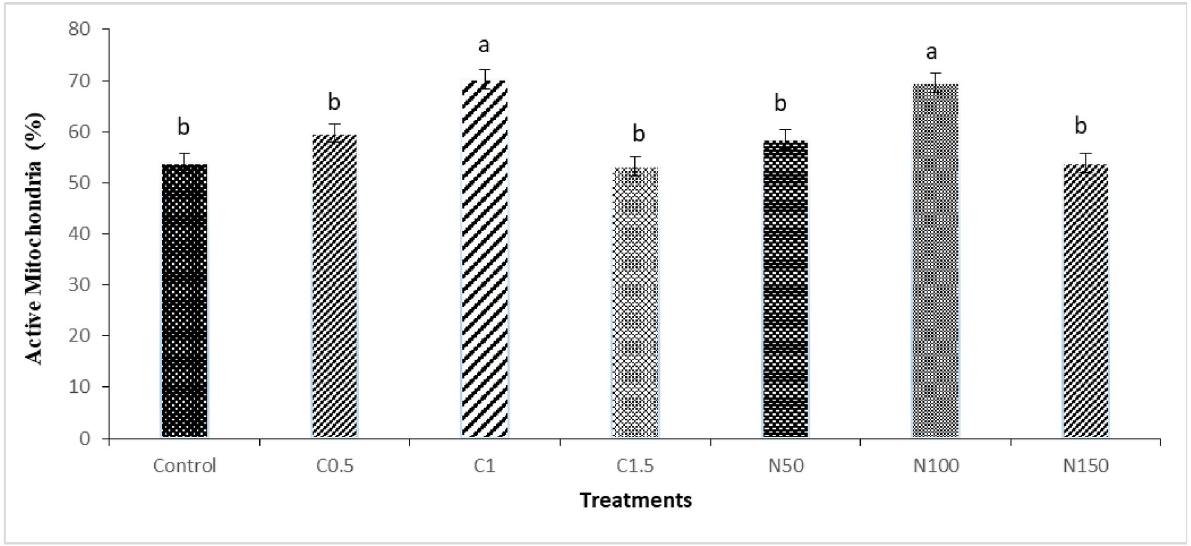
Fig 6. Effect of crocin and naringenin supplementation in cryopreservation medium on post-thawed active mitochondria (%, R123+/PI-) of rooster sperm. Beltsville extender without antioxidant (control), C0.5 (Beltsville extender with 0.5 mM crocin), C1 (Beltsville extender with 1 mM crocin), C1.5 (Beltsville extender with 1.5 mM crocin), N50 (Beltsville extender with 50 μ M naringenin), N100 (Beltsville extender with 100 μ M naringenin), N150 (Beltsville extender with 150 μ M